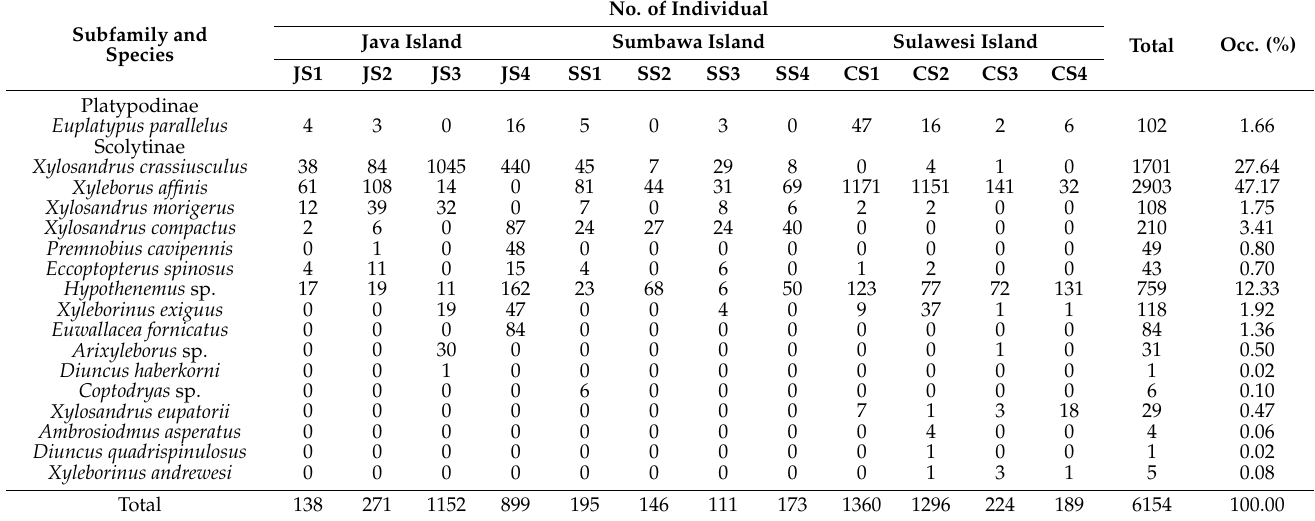
Table 2. The ambrosia beetle species were collected on twelve sites of teak plantations in Java, Sumbawa, and Sulawesi